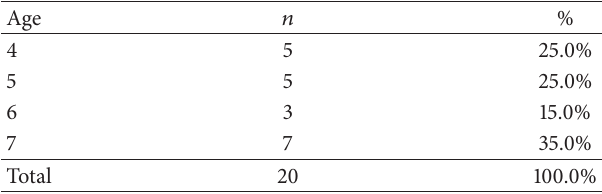
Table 3: Frequency of scores given by